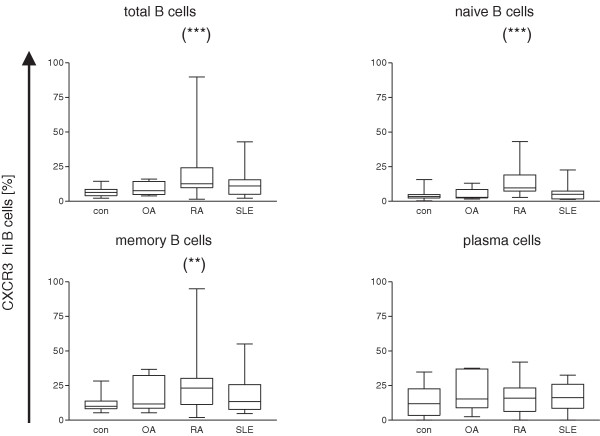
Chemokine receptor CXCR3hi expression on B cell subpopulations. The percentage of total B cells, naive B cells, memory B cells and plasma cells expressing CXCR3hi are given. Box plots show the median values, 25th and 75th quartile and the range of values. Significant differences from controls are shown (**P < 0.005, ***P < 0.0005).